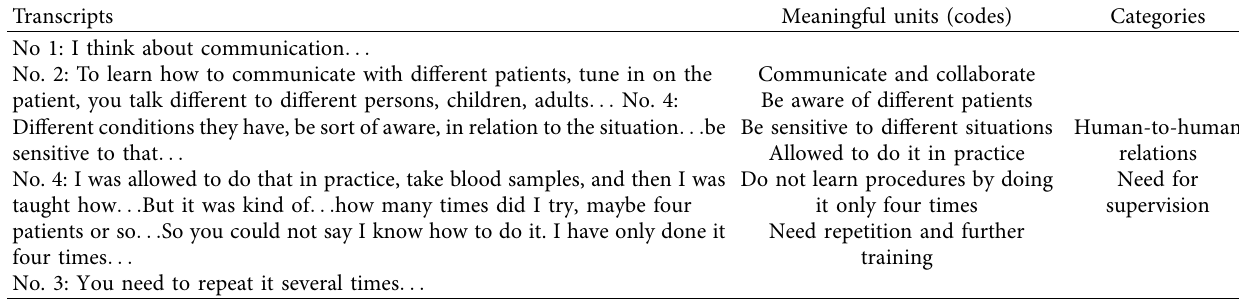
Table 1: Example of the analysis process.